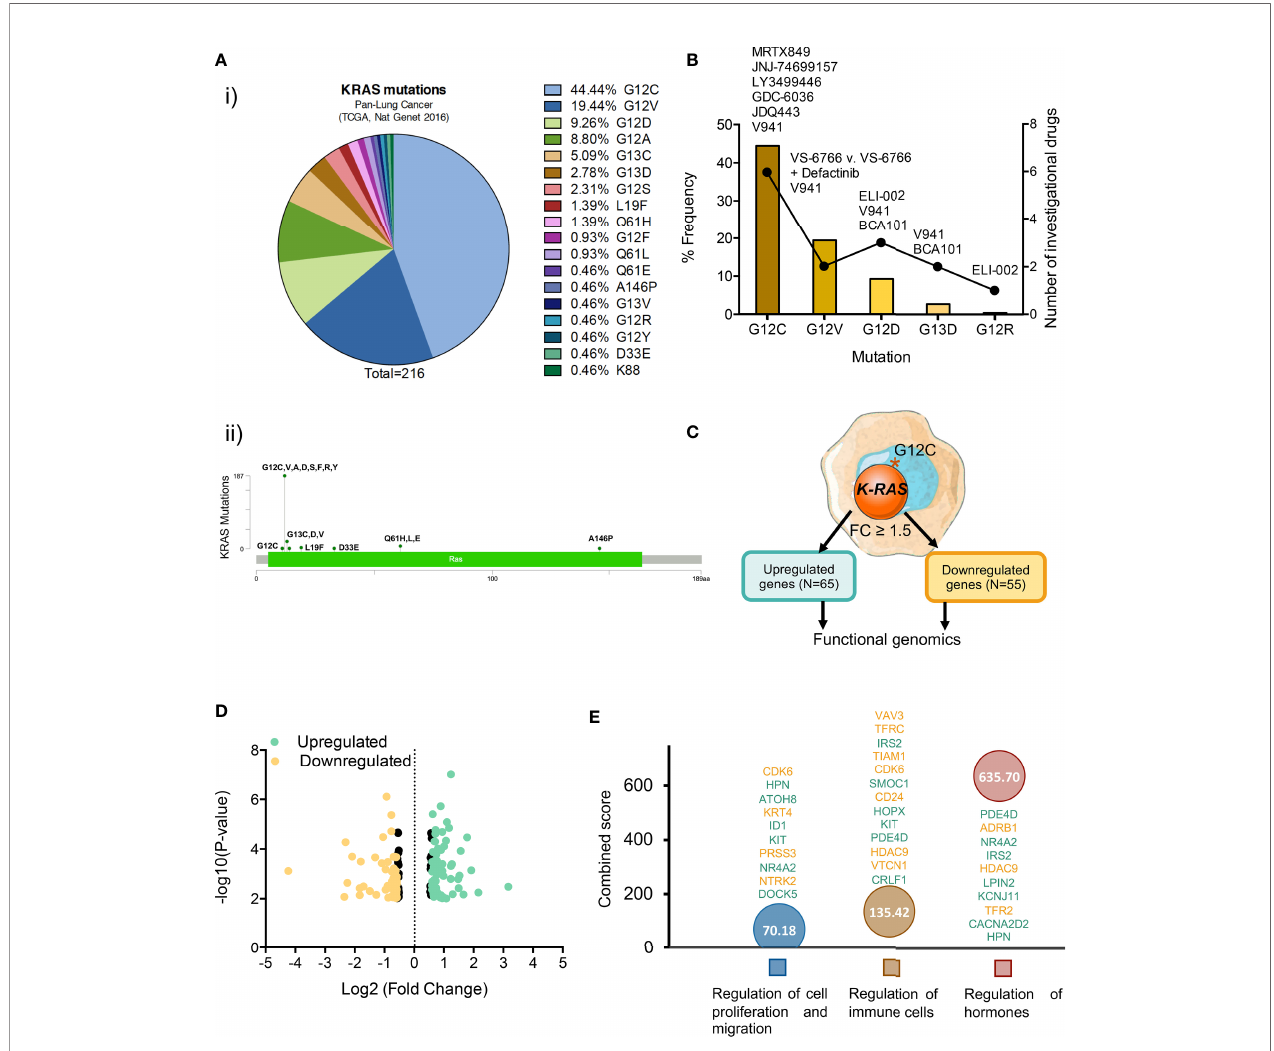
FIGURE 1 | Most common K-RAS mutations in patients with NSCLC and investigational drugs against these mutations. (A) (i) Frequency of K-RAS mutations in NSCLC patient population (ii) Distribution of mutations identi fi ed in patients with lung adenocarcinoma along K-RAS gene. (B) Dot chart showing the number of investigational drugs and bar graph representing the percentage frequency of most common K-RAS mutations (C) Flow chart of the process followed to select upregulated (N=65) and downregulated (N=55) differentially expressed genes. (D) Volcano plot of statistic signi fi cant deregulated genes highlighted in color (yellow for down and green for upregulated) those with fold change equal or higher than 1.5. (E) Graph showing the biological processes of the selected 120 genes with higher combine